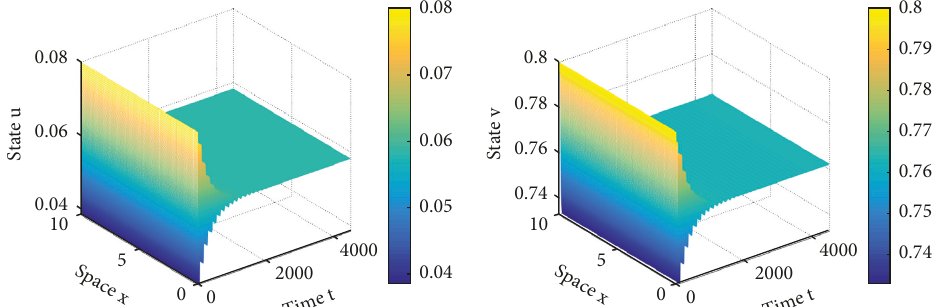
Figure 8: The evolution process of node u ( t ) and v ( t ) in system (9) when D